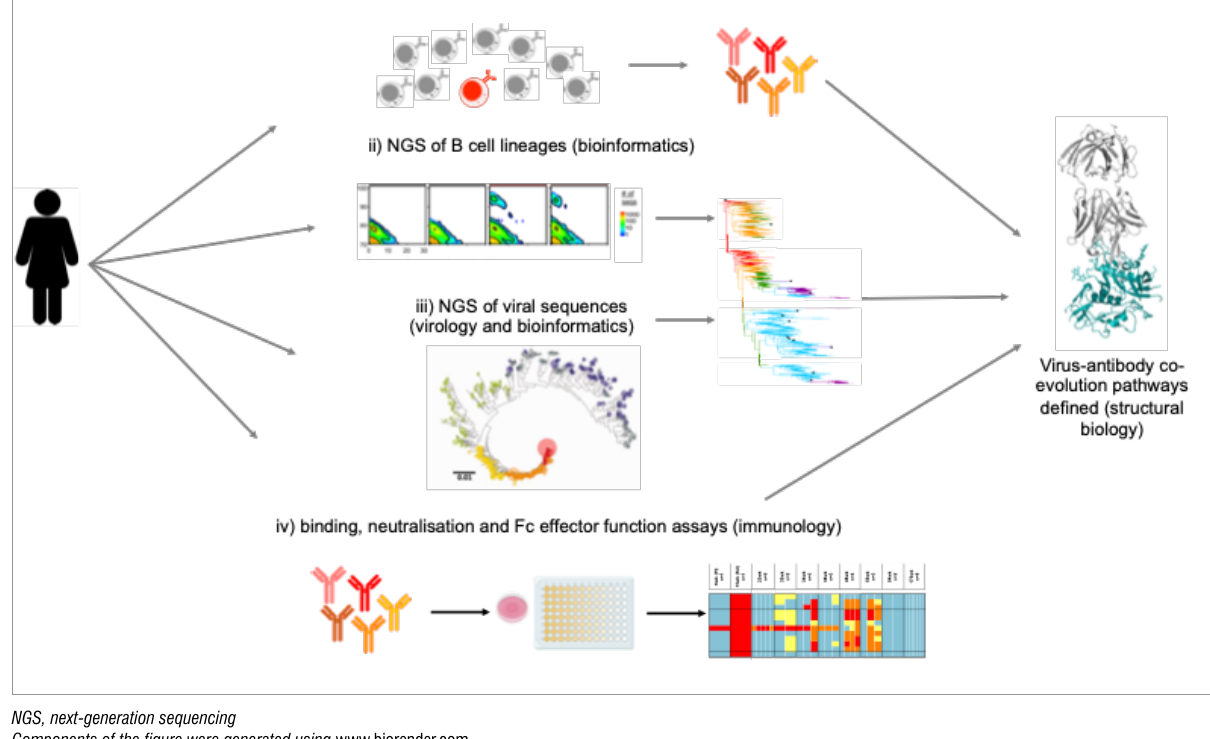
NGS, next-generation sequencing Components of the figure were generated using www.biorender.com Tools used in HIV research that have been pivoted towards SARS-CoV-2 research. The Laboratory has focused on characterising the antibody response in HIV-infected individuals as well as tracking the evolution of the virus over time. We have used our combined skills across multiple platforms to answer key questions in the HIV field and have adapted these technologies to study antibody responses to